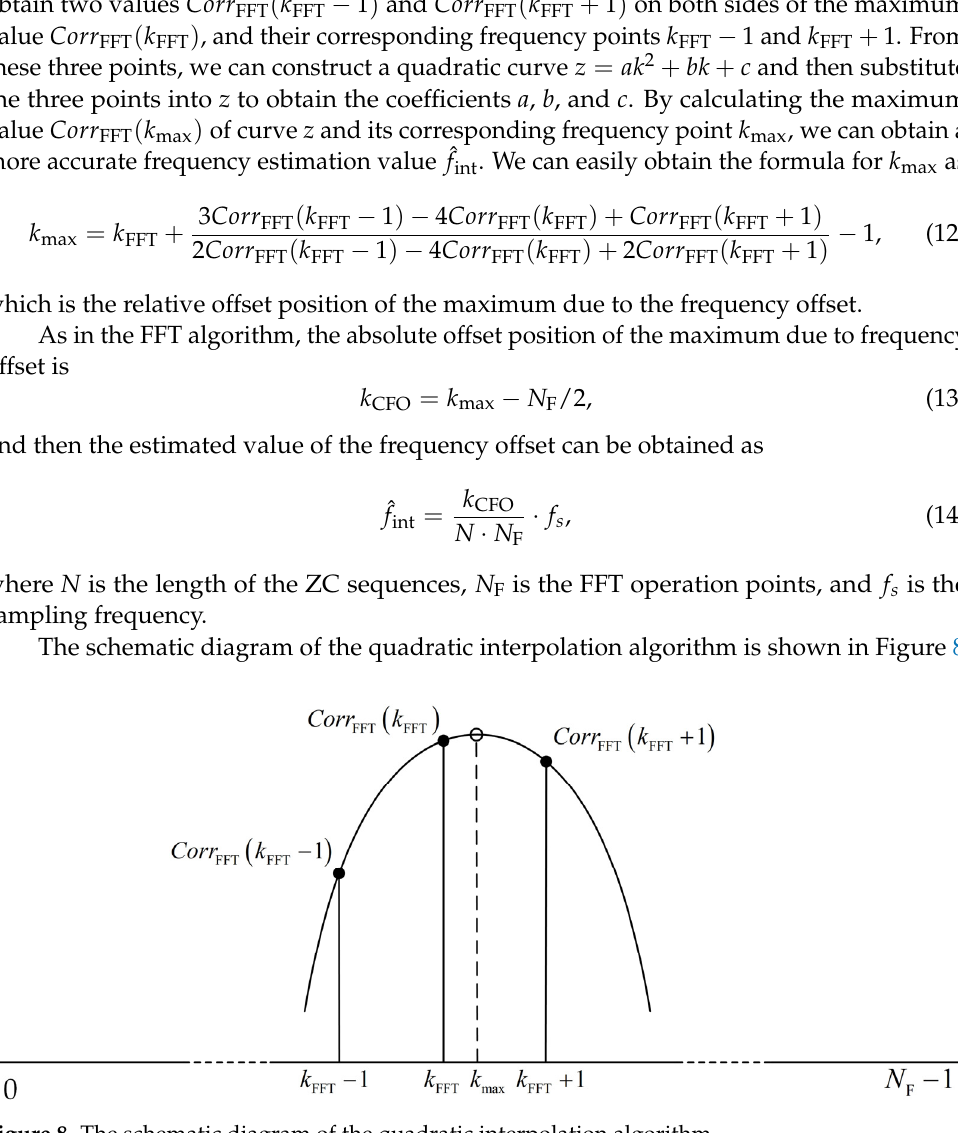
Figure 8. The schematic diagram of the quadratic interpolation